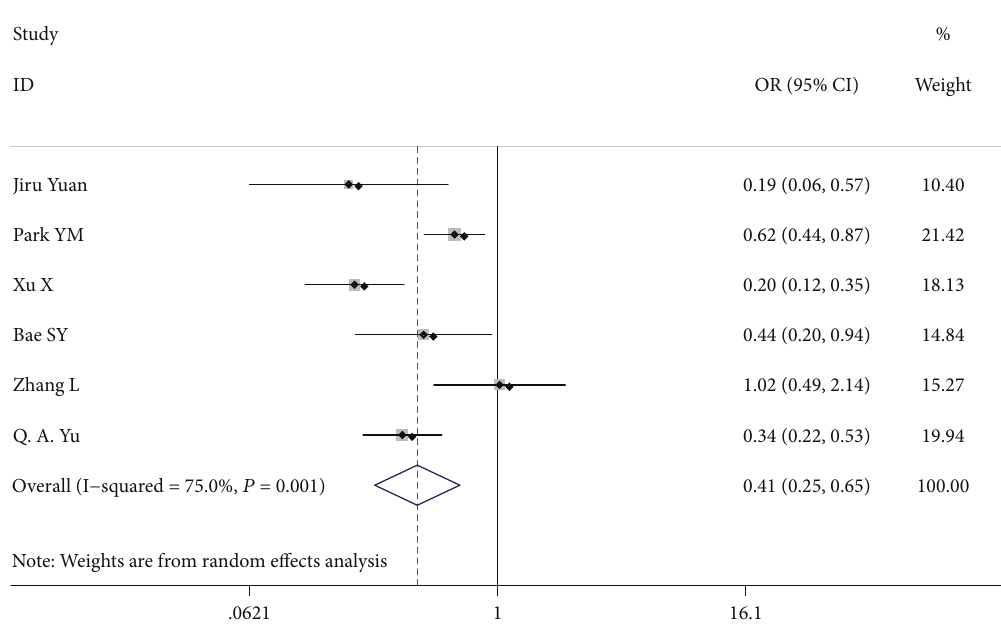
Figure 7: Forest plot for metastasis according to capsule